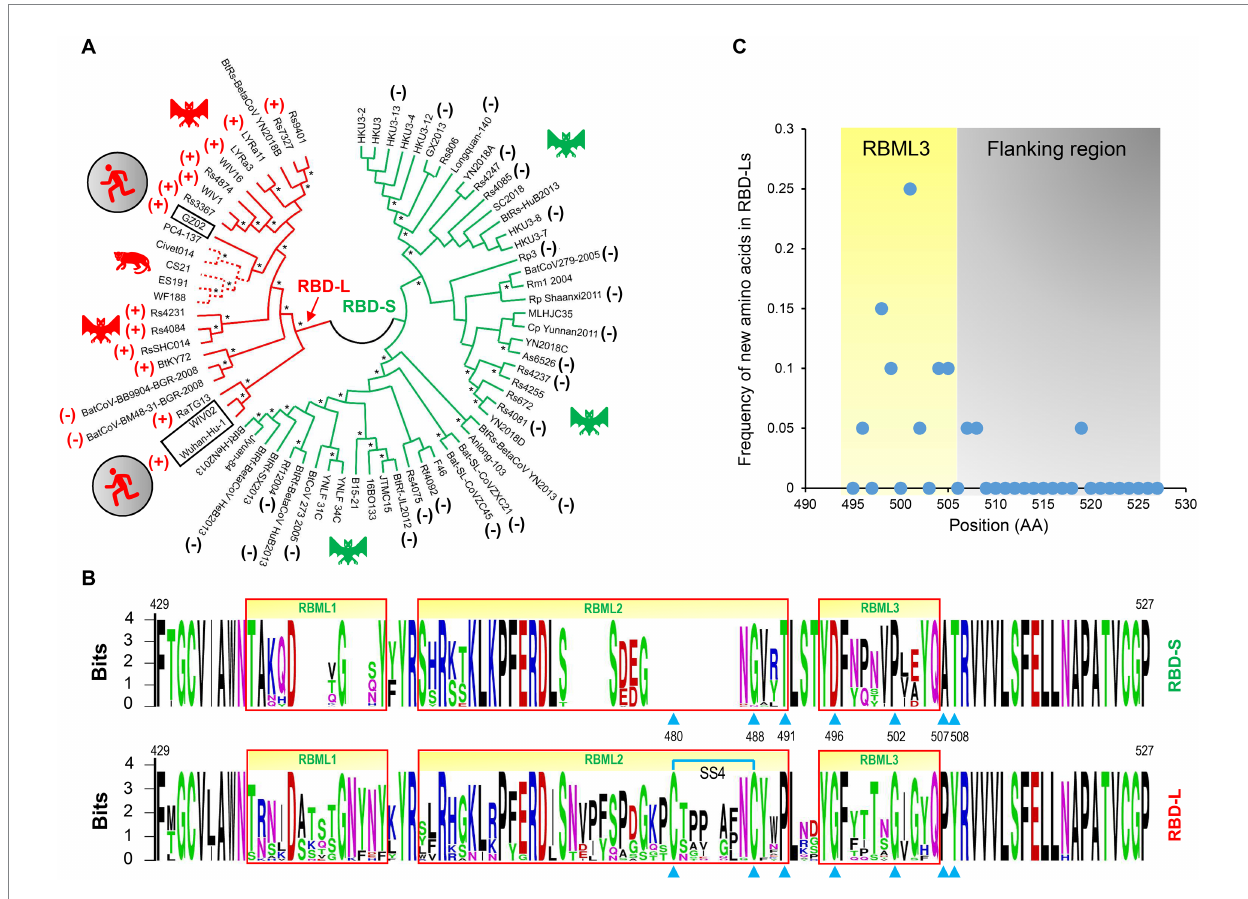
FIGURE 3 The classification and evolutionary conservation of Sarbecovirus RBDs. (A) The phylogeny-based classification. The tree was constructed by MEGA with the NJ method based on p -distance model of amino acid substitutions (NJp). Asterisks shown at nodes indicate the braches supported by up to 50% bootstrap based on 500 replicates. Two subfamilies differentiated by the tree are denoted as RBD-L (shown in red) and RBD-S (shown in green) based on their loop length. RBDs known to use ACE2 are marked by plus signs and those incapable of binding ACE2 by minus signs (data derived from Ren et al., 2008; Hu et al., 2017, 2018; Letko et al., 2020; Roelle et al., 2022; Starr et al., 2022). Hosts of the viruses, including bats, palm civet and human, are shown here. (B) The evolutionary conservation of RBDs analyzed by “Weblogo.” The three loops are boxed in red and positions as tree determinants are indicated by cyan triangles. Top: RBD-S. Bottom: RBD-L. The SS4 in RBD-L is indicated by cyan lines. (C) Comparison of the frequency of new amino acids emergence in RBML3 and its flanking